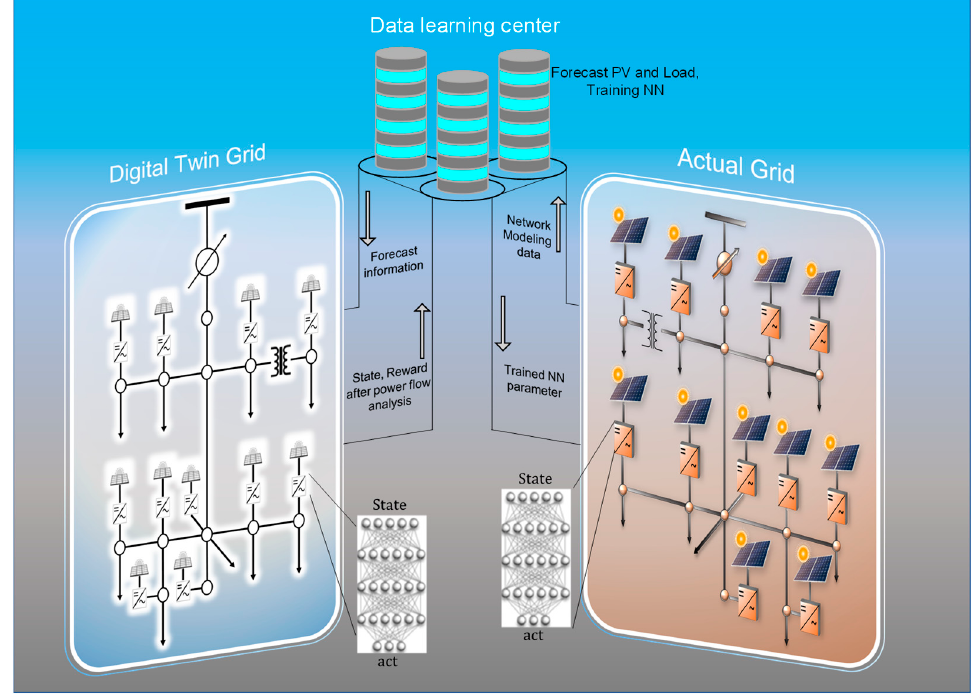
Figure 1. Day-ahead training in data learning center using a digital twin grid and implemented in an actual grid platform.